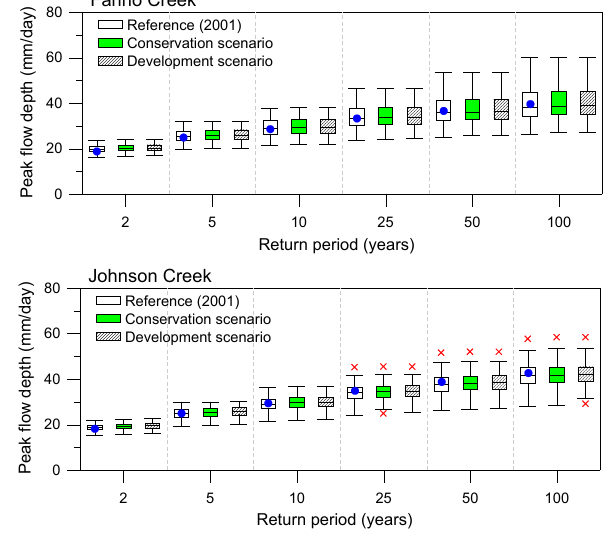
Fig. 7. Variation of flood frequency by land use change scenarios, with recurrence intervals of 2, 5, 10, 25, 50, and 100 years for the 2050s with respect to the reference period of 1960-1989. The blue dot indicates flood frequency using observed climate data, and symbol (x) indicates outliers.